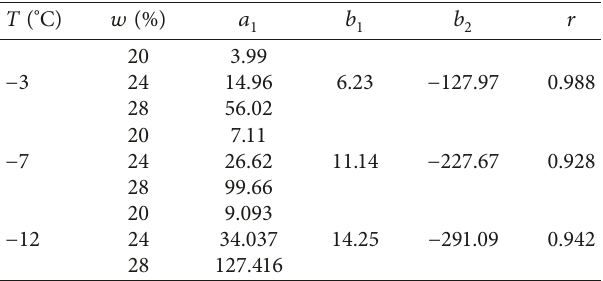
Table 6: Values for the coefficients b coefficient r